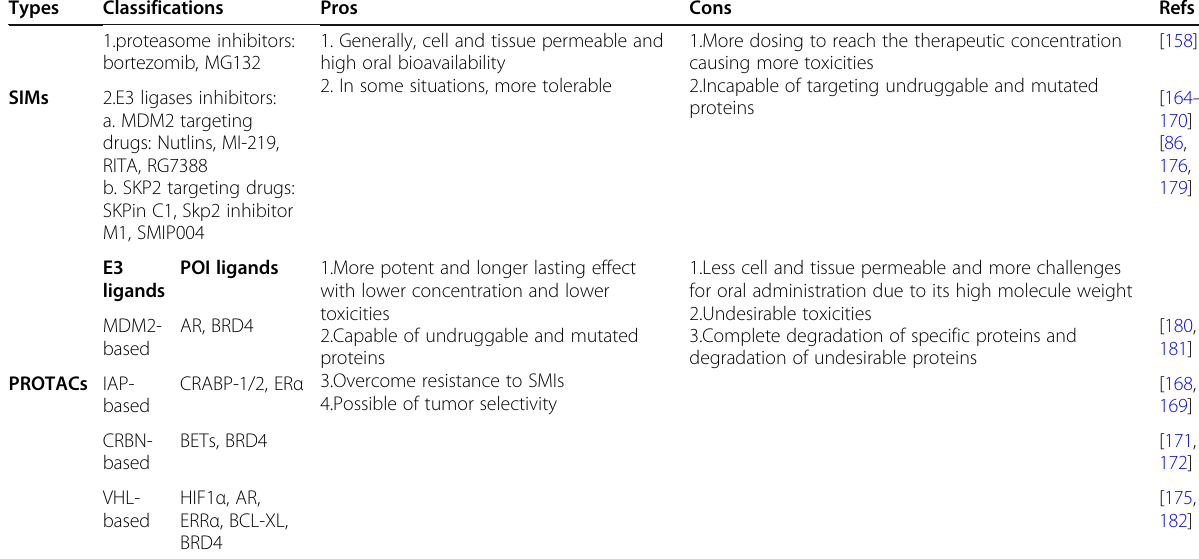
Table 2 Description of the classifications, Pros and Cons between PROTACs and small molecule inhibitors (SMIs)